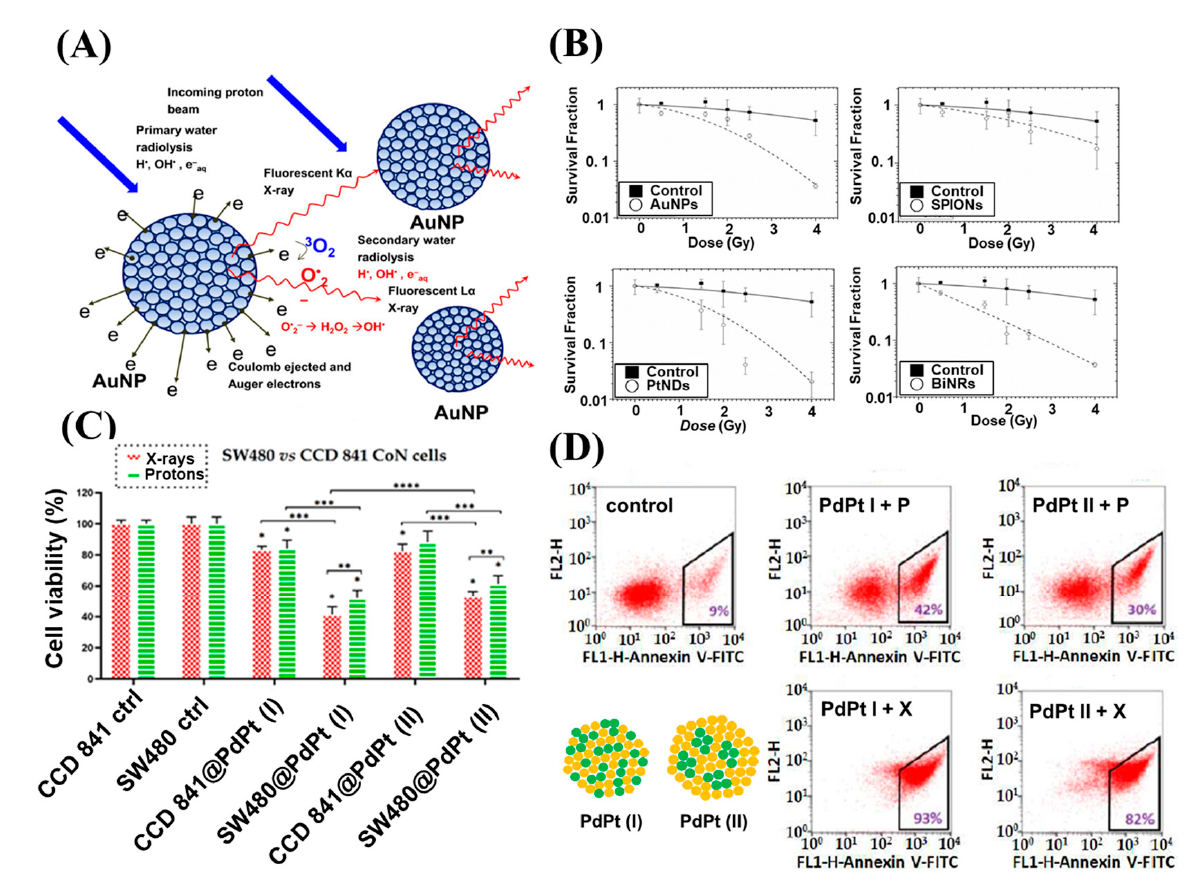
Figure 4. ( A ) A schematic diagram of low-energy electrons (LEEs) and enhanced ROS generation from proton-stimulated high-Z NPs via Coulomb decay path. ( B ) Survival curve as a function of